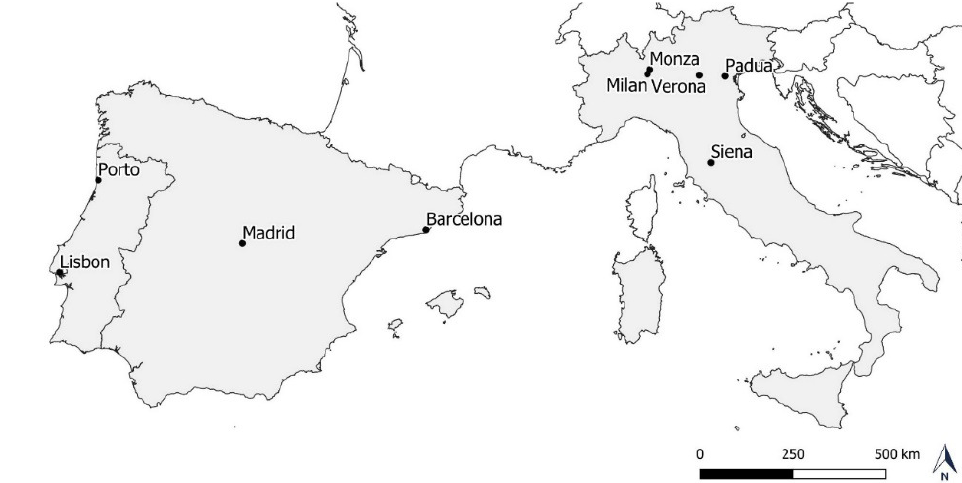
Figure 1. Case studies: Southern European countries and respective cities. urban and building regulations related to cultural her‐ itage in urban areas of the three selected countries: Italy, Spain, and Portugal. Beyond the national rules, regula‐ tions related to the regions and municipalities where the institutional stakeholders carry out their duties were Table 1. Interviewed public institutions involved in urban and building regulations’ development and implementation.